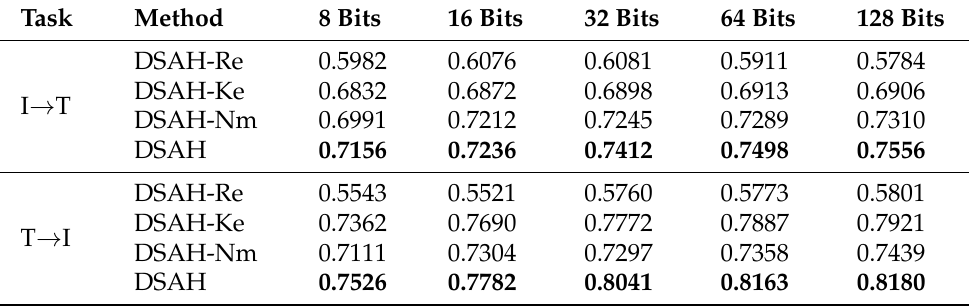
Table 4. mAP scores of different ablated versions of DSAH on MIRFlickr dataset.